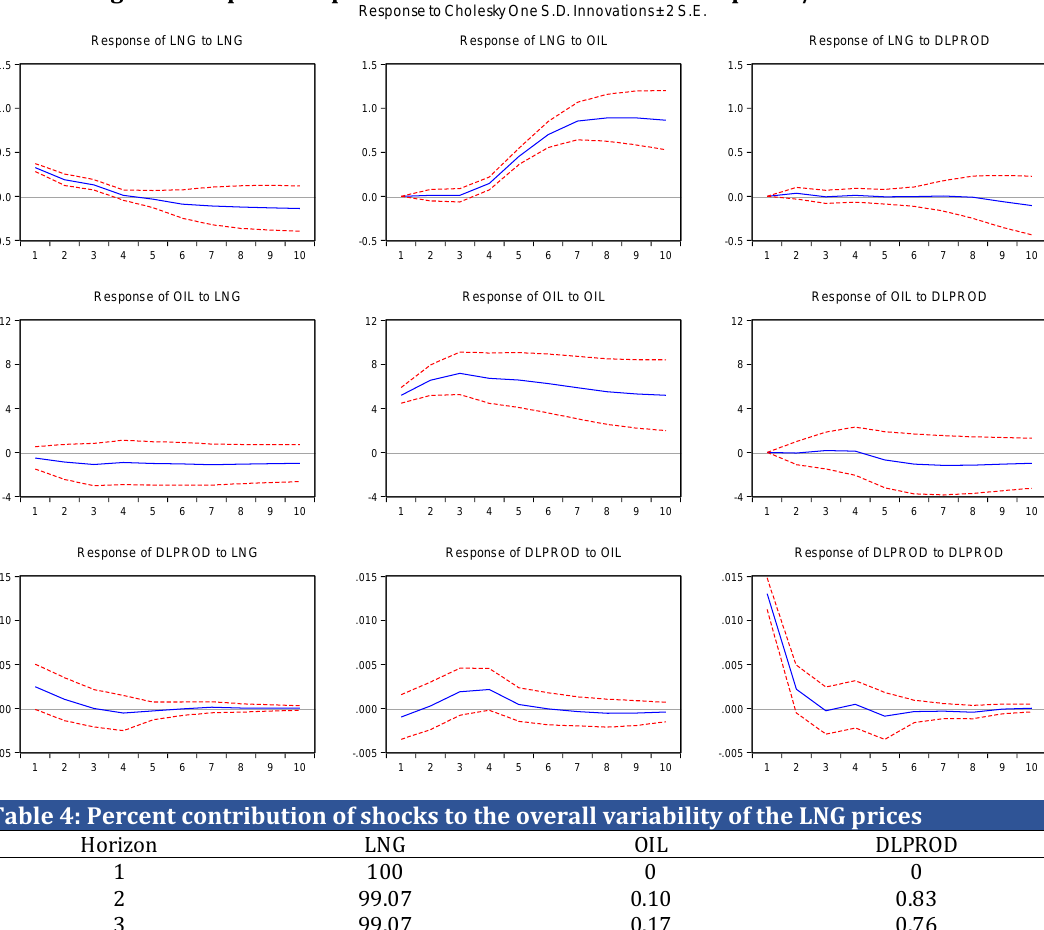
Figure 3: Impulse responses of structural shocks to LNG prices/ 2009-2017